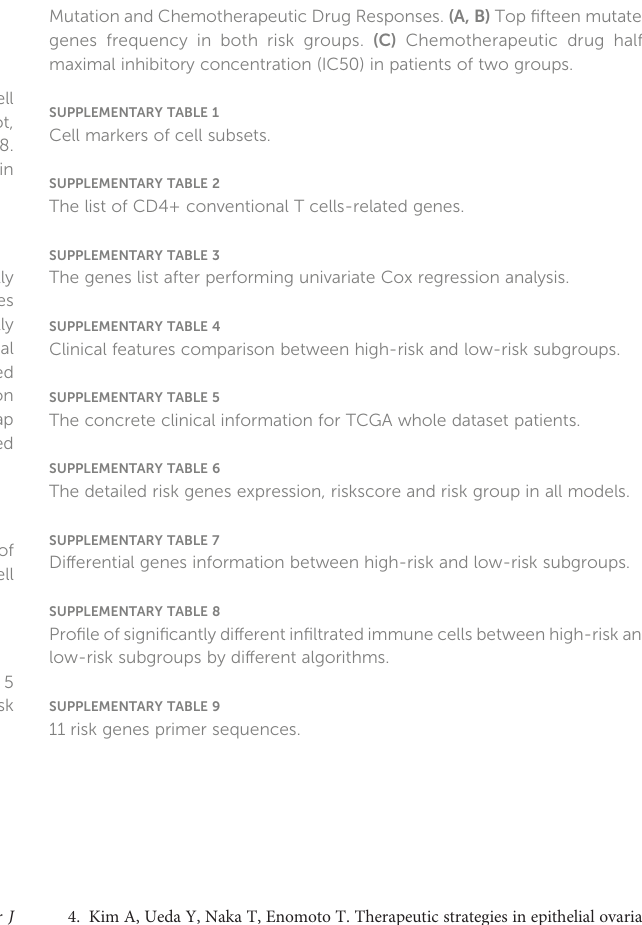
SUPPLEMENTARY FIGURE 6 The expression levels of the genes selected for risk pattern analysis in single-cell dataset. (A) In single-cell dataset GSE118828 by dotplot. (B) In single-cell dataset GSE118828 by violin plot. (C) In single-cell dataset GSE147082 by dotplot. (D) In single-cell dataset GSE147082 by violin plot. (E) The risk score calculated by AddModuleScore function was displayed in cell subsets level in datasets GSE118828 and GSE147082. (F) The risk score calculated by AddModuleScore function was displayed in sample level in datasets GSE118828 and GSE147082. SUPPLEMENTARY FIGURE 7 The risk genes expression in bulk-seq datasets. (A) In dataset TCGA by violin plot. (B) In dataset GSE63885 by violin plot. (C) In dataset GSE26193 by violin plot. (D) In dataset GSE147082 by violin plot. SUPPLEMENTARY FIGURE 8 The risk gene expression in two ovarian cancer celllines (SKOV3, A2780) and one normal ovarian celline (ISOE). (A) The 11 risk genes expression, and were normalized to gene expression in celline ISOE. SUPPLEMENTARY FIGURE 9 Mutation and Chemotherapeutic Drug Responses. (A, B) Top fi fteen mutated